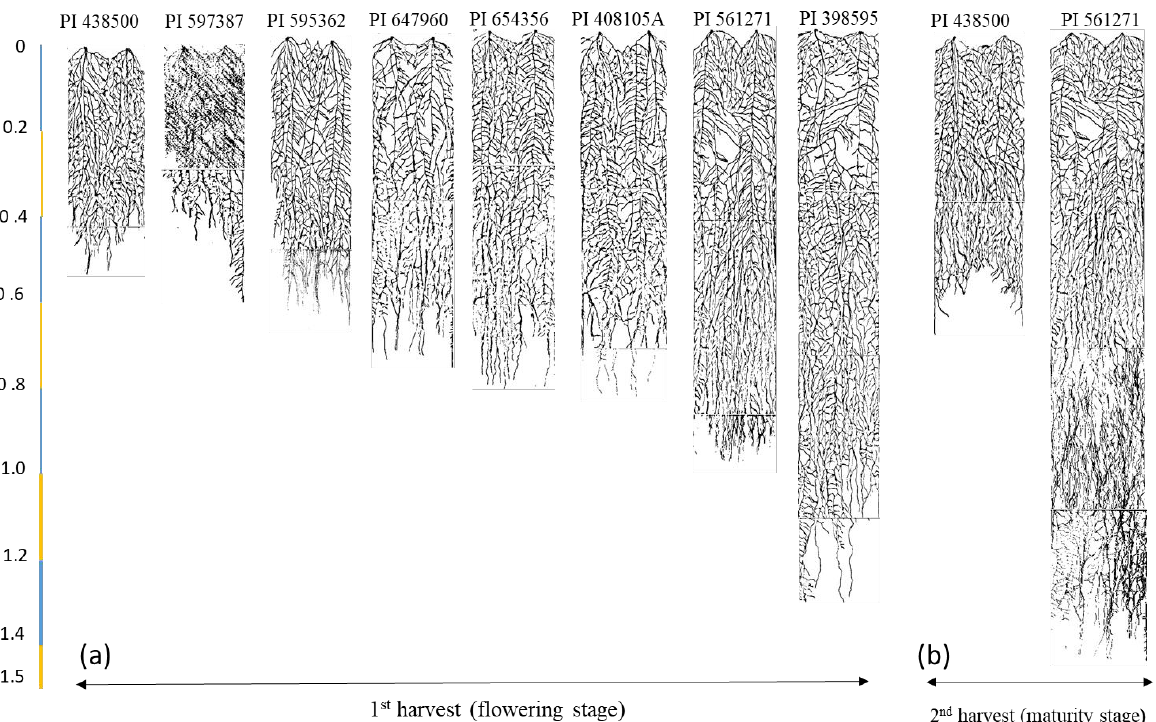
0.05, p < 0.01, and p < 0.001, respectively. p < 0.01, and p < 0.001, respectively.